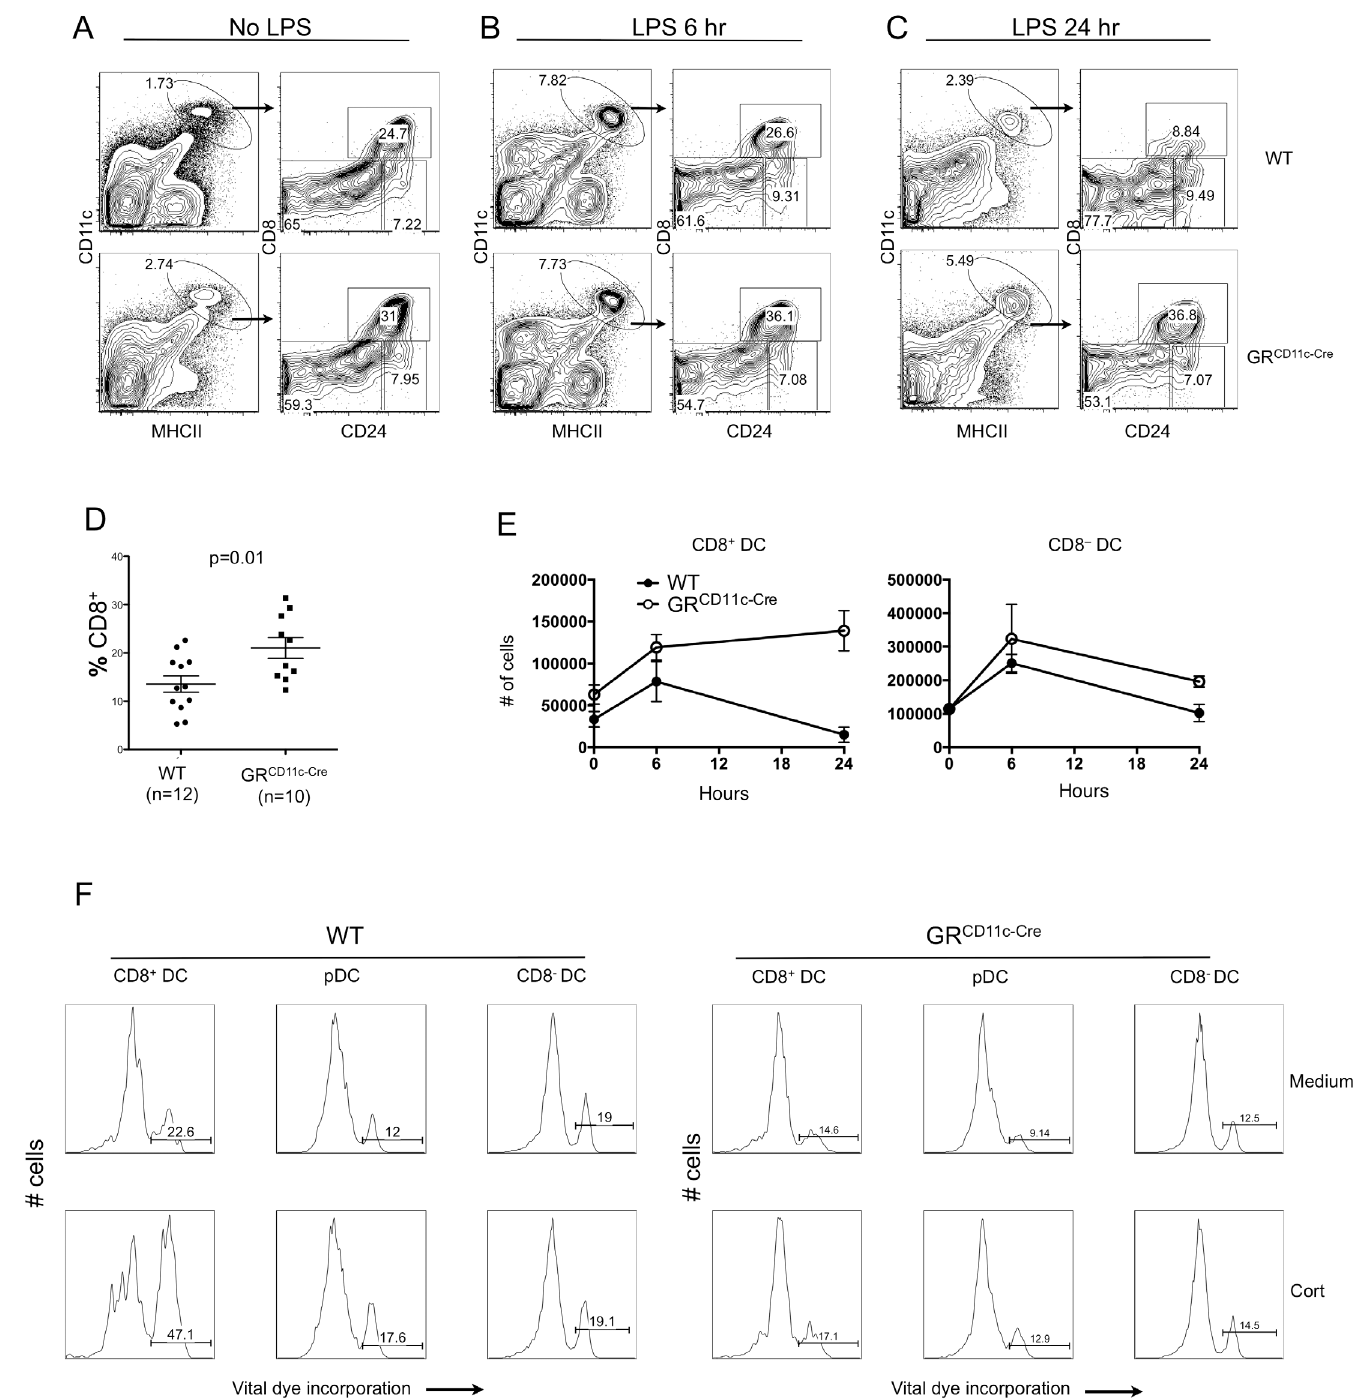
Fig 4. LPS-induced loss of CD8 + DCs is GR-dependent. (A – C) Splenic DCs from WT and GR CD11c-cre B10.A mice were analyzed by flow cytometry at indicated times after injection with LPS (3 μ g/g body weight). Only B220 − TCR β − cells are shown. Results shown are from one representative experiment of three independent ones, each with three to five mice per group (D) Percentage of CD8 + DCs in WT and GR CD11c-cre mice at time 0 (steady state). Results shown are from three pooled independent experiments, with 3 – 4 mice per group. (E) Total number of CD8 + and CD8 − DCs at time 0, 6 hr, and 24 hr post LPS injection. Results shown are from one representative experiment of three independent ones, each with three to five mice per group. (F) Sensitivity of DC subsets to GC-induced death in vitro. Total splenocytes from WT and GR CD11c-cre mice were incubated with 100 nM corticosterone in vitro for 6 hr, and the percentage of dead cells in indicated populations are shown. The data shown are representative of four pairs of mice in two independent experiments. The data used to make this figure can be found in S1